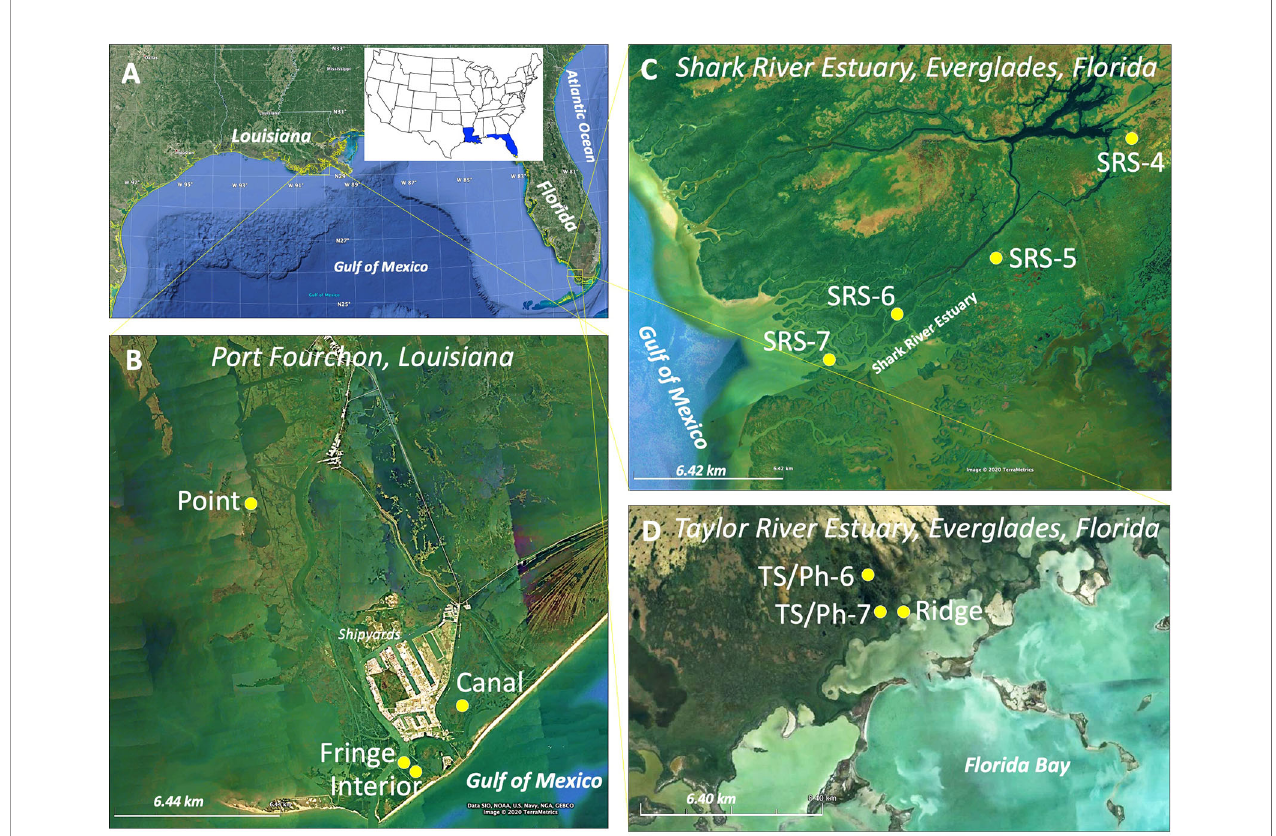
FIGURE 2 | (A) Study sites in Port Fourchon (PF), coastal Louisiana and Florida Coastal Everglades (FCE), South Florida; and (B) Four mangrove-saltmarsh ecotone sites: Canal, Interior, Fringe, and Point in Port Fourchon; (C) Four riverine mangrove sites along the Shark River estuary (SRE) from upstream (SRS-4) to midstream (SRS-5), downstream (SRS-6), and estuary mouth (SRS-7); and (D) two scrub (TS/Ph-6 and TS/Ph-7) and one fringe (Ridge) mangrove sites at the Taylor River estuary